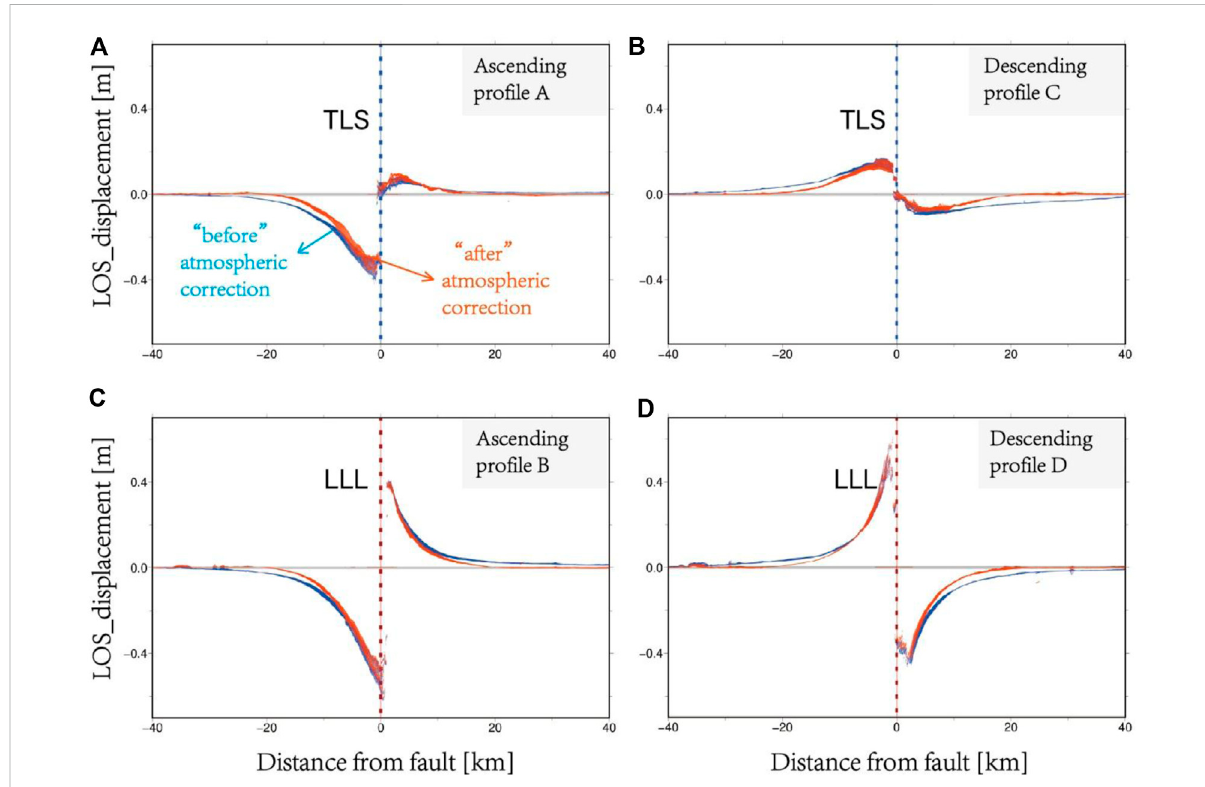
FIGURE 4 LOS displacement pro fi les, which are indicated in Figure 3. Pro fi les (A,C) are perpendicular to the TLSF, and pro fi les (B,D) are perpendicular to the